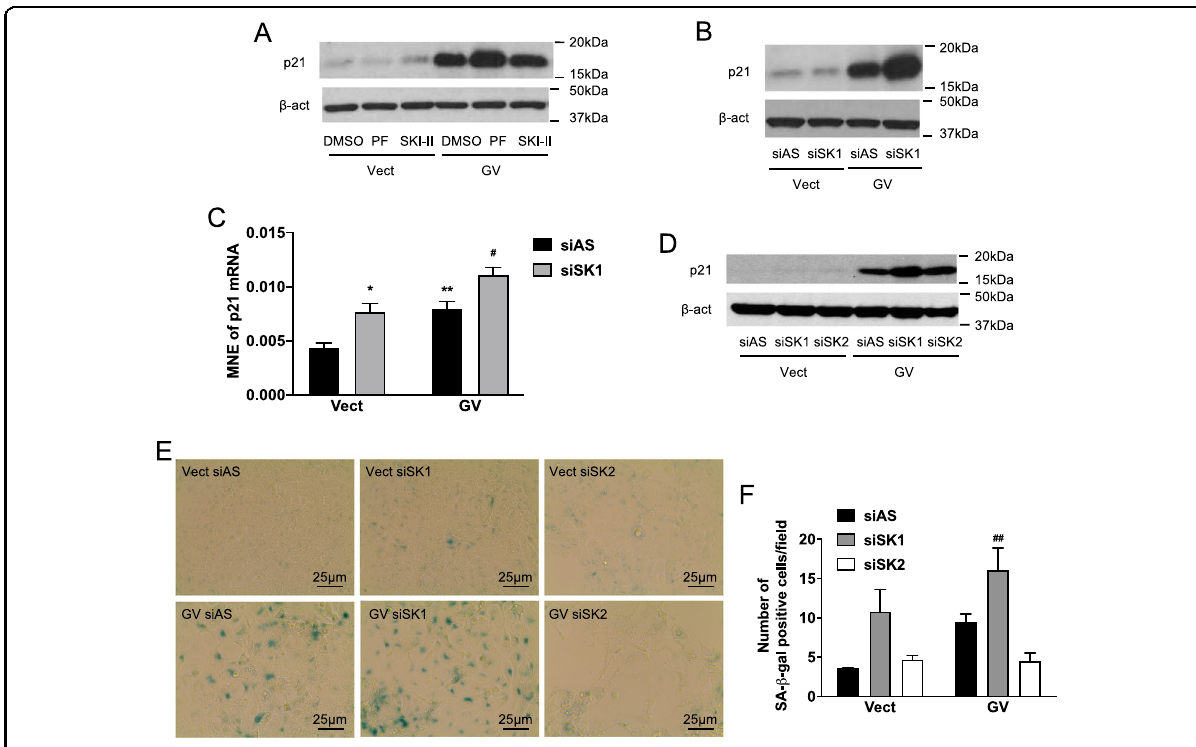
Fig. 4 SK1 inhibition enhances senescence induced by oncogenic K-Ras overexpression. A Western blot analysis of p21 expression in cells overexpressing Vect or GV K-Ras. Cells were plated and treated the next day with pharmacological inhibitors PF-543 (100 nM) or SKI-II (10 μ M) for 72 h. Proteins were extracted and p21 expression analyzed. B Western blot analysis of p21 expression in cell lysates from cells overexpressing Vect or GV K- Ras. Cells were plated and transfected the next day with siRNA control (AS) or SK1 (20 nM) for 72 h. Cells were then lysed and the protein level of p21 was determined. C Analysis of p21 expression by RT-qPCR in cells overexpressing Vect or GV K-Ras. Cells were plated and transfected the next day with control (AS) or SK1 siRNA (20 nM) for 72 h. Cells were then scraped and RNA extracted. cDNA was synthesized and used as a template for the RT- qPCR. Actin was used as a housekeeping gene. The mean normalized expression of p21 mRNA was determined by using the Ct values ( N = 5, data are presented as mean ± SEM, two-way ANOVA with Tukey ’ s multiple comparisons test, * means p < 0.05 comparing the group tested to Vector control siRNA, # means p < 0.05 comparing the group tested to GV control siRNA). D Western blot analysis of p21 expression in protein lysates of cells overexpressing Vect or GV mutant K-Ras were treated for 72 h with siRNA control (AS) or directed against SK1 or SK2 (20 nM). E SA-ß-gal assay in cells overexpressing Vector or GV K-Ras. Cells were plated and transfected the next day with control (AS) or SK1 or SK2 siRNA (20 nM) and kept in